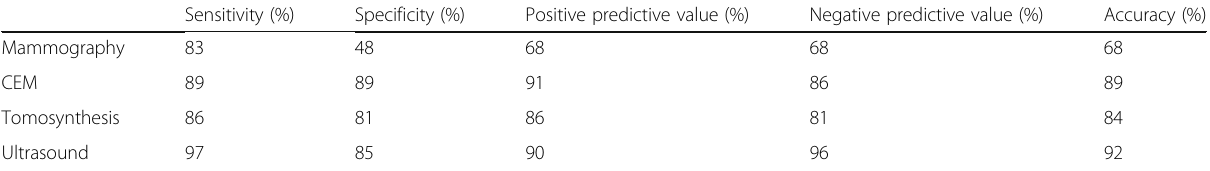
Table 3 Comparison of diagnostic indices of mammography, CEM, tomosynthesis, and breast ultrasound